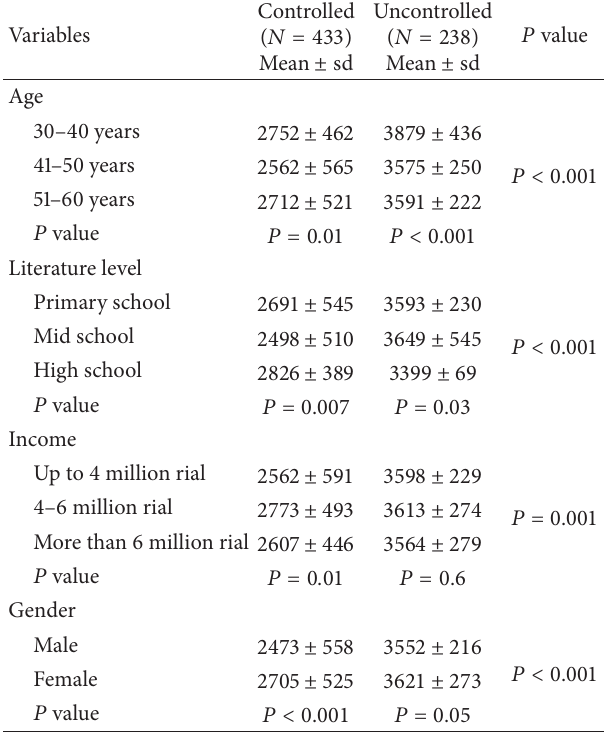
Table 3: Mean and standard deviation studied variables among controlled and uncontrolled hypertensive patients.